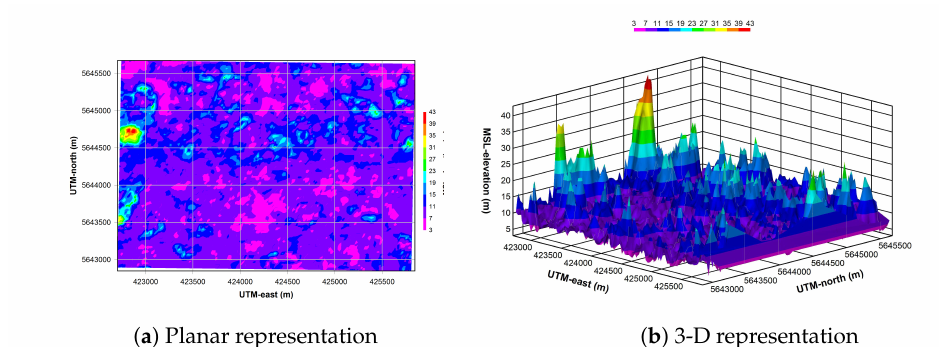
Figure 4. ASTER V2 elevation levels in the vicinity of the OSM road network.